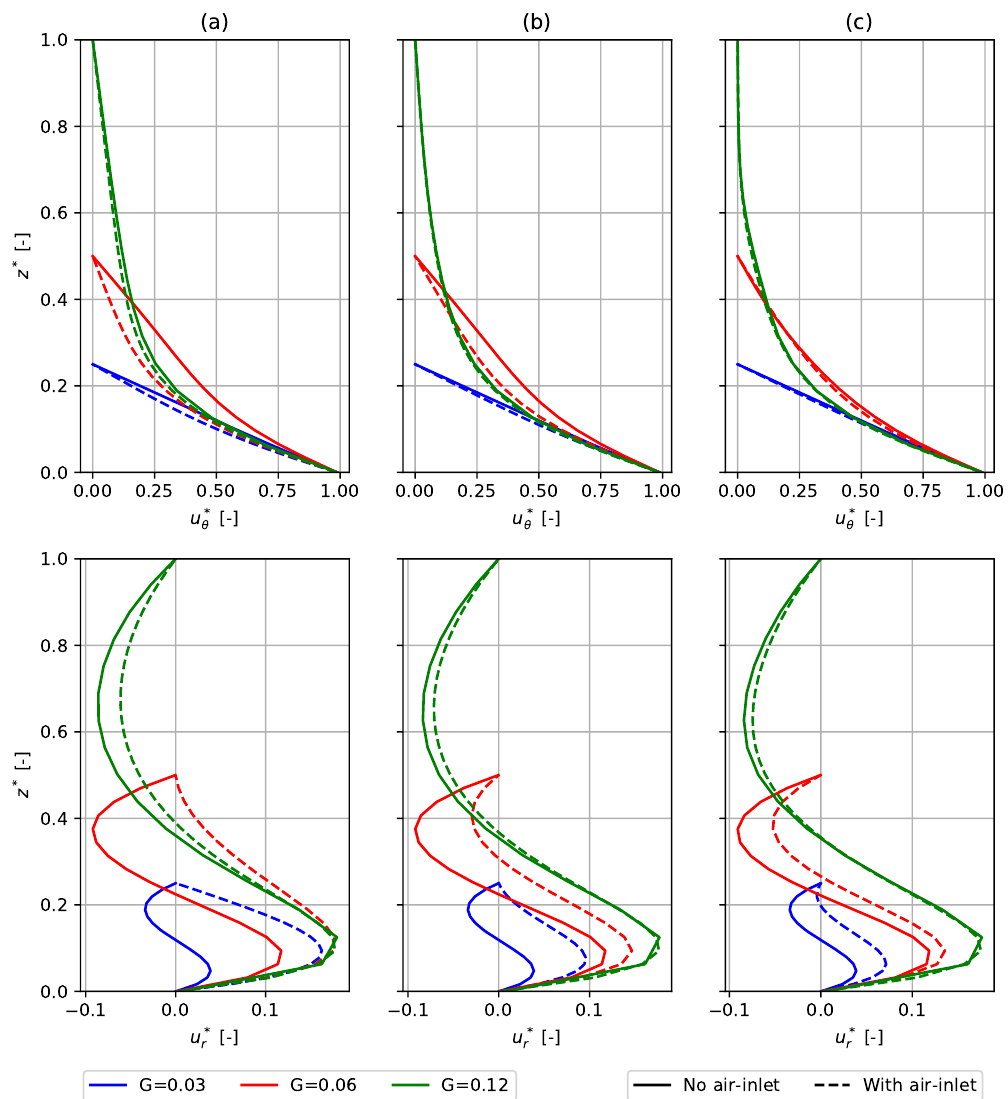
Figure 18. Velocity profiles corresponding to Re = 5513 inside the AFPM machine for different configurations and gap- length ratios, G. ( a – c ), respectively, correspond to the dimensionless radial position r ∗ = r / R = 0.52, 0.73, 0.93. The remaining normalized values are: the tangential and radial velocity components, u ∗ gap-length z ∗ = z / d max , where z ∗ = 0 corresponds to the